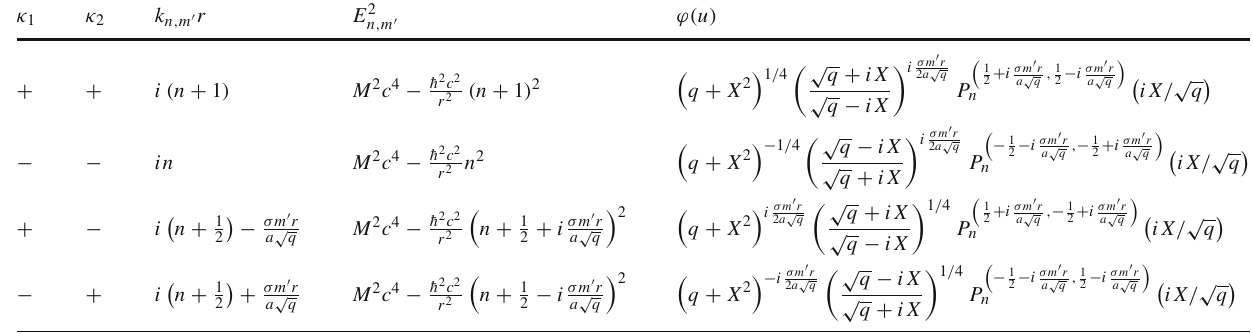
Table 1 The wave vector along the u direction k n , m (cid:2) , the energy levels E n , m (cid:2) , and the solutions ϕ( u ) of the Dirac equation in two dimensional wormhole with constant magnetic flux through the throat of the wormhole